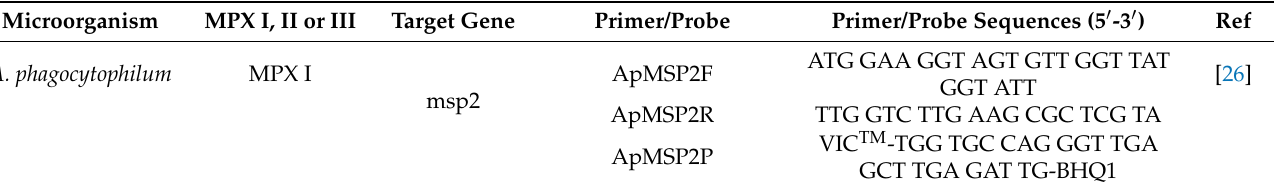
Table 2. Primer pairs and probes used in this study for the validation of the multiplex qPCR assays. In order to differentiate between the different TBPs within the same multiplex assay, the 5 (cid:48) -end Atto425 probe dye labels were replaced by FAMTM, VICTM and TexRedTM probe dye labels in the multiplex